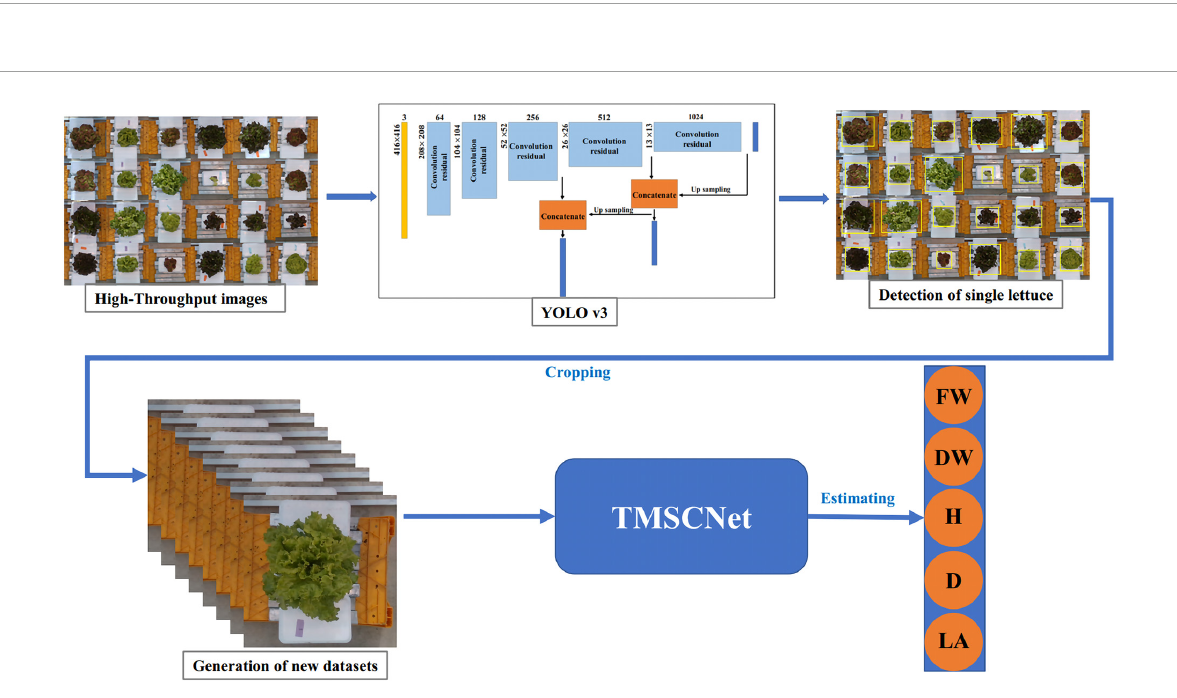
FIGURE13 The process of lettuce traits estimation in the high-throughput situation. The lettuce in the high-throughput image is detected based on YOLO v3, and then the detected lettuce is cropped out from the high-throughput image to form new datasets containing only single lettuce. Finally, after data processing, it is inputted to the TMSCNet to estimate the lettuce